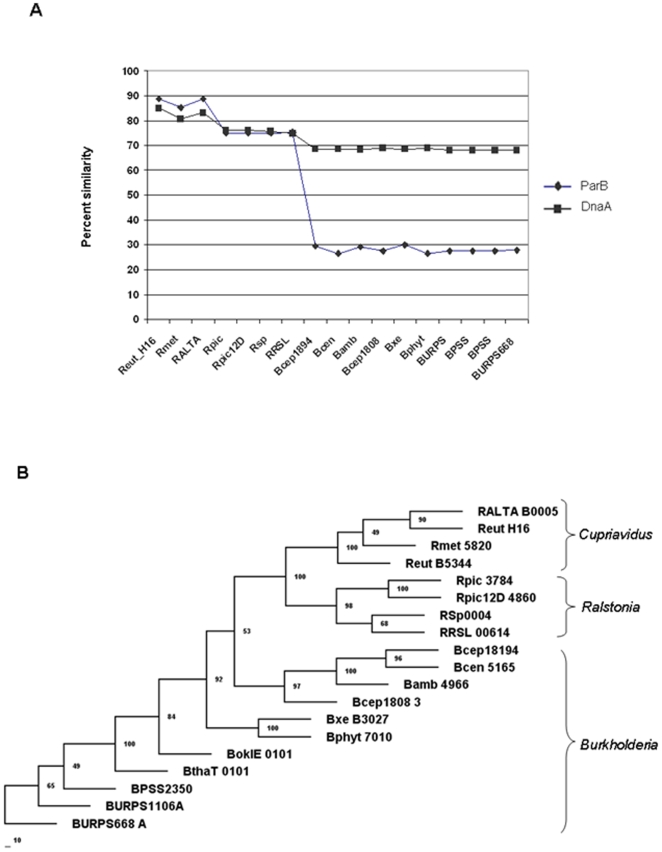
ParB protein similarity and phylogeny.A. Percent identity plots of C. necator ParB (Reut_B5344) and DnaA (Reut_A0001) proteins. B. ParB phylogeny. Neighbor joining tree of 19 ParB proteins. Sequences are from the following species: RALTA, Cupriavidus taiwanensis; Reut_H16, Cupriavidus necator H16; Rmet, Cupriavidus metallidurans CH34; Rpic, Ralstonia pickettii 12J; Rpic12D Ralstonia pickettii 12D; RSp, Ralstonia solanacearum GMI1000; RRSL, Ralstonia solanacearum UW551; Bcep18194, Burkholderia sp. 383; Bcen, Burkholderia cenocepacia AU 1054; Bamb, Burkholderia cepacia AMMD; Bcep1808, Burkholderia vietnamiensis G4; Bxe, Burkholderia xenovorans LB400; Bphyt, Burkholderia phytofirmans PsJN; BokIE, Burkholderia oklahomensis EO147; BthaT, Burkholderia thailandensis TXDOH; BPSS, Burkholderia pseudomallei K96243; BURPS1106, Burkholderia pseudomallei 1106a; BURPS668, Burkholderia pseudomallei 668. The corresponding tree built for ParA was similar (not shown).